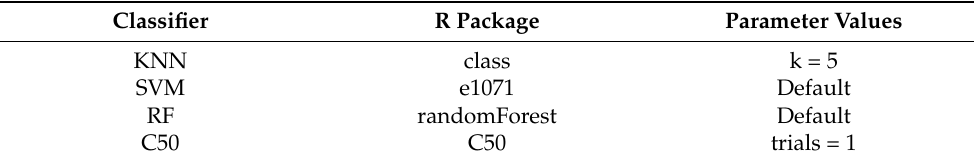
Table 2. Summary of classifier and applied parameters.